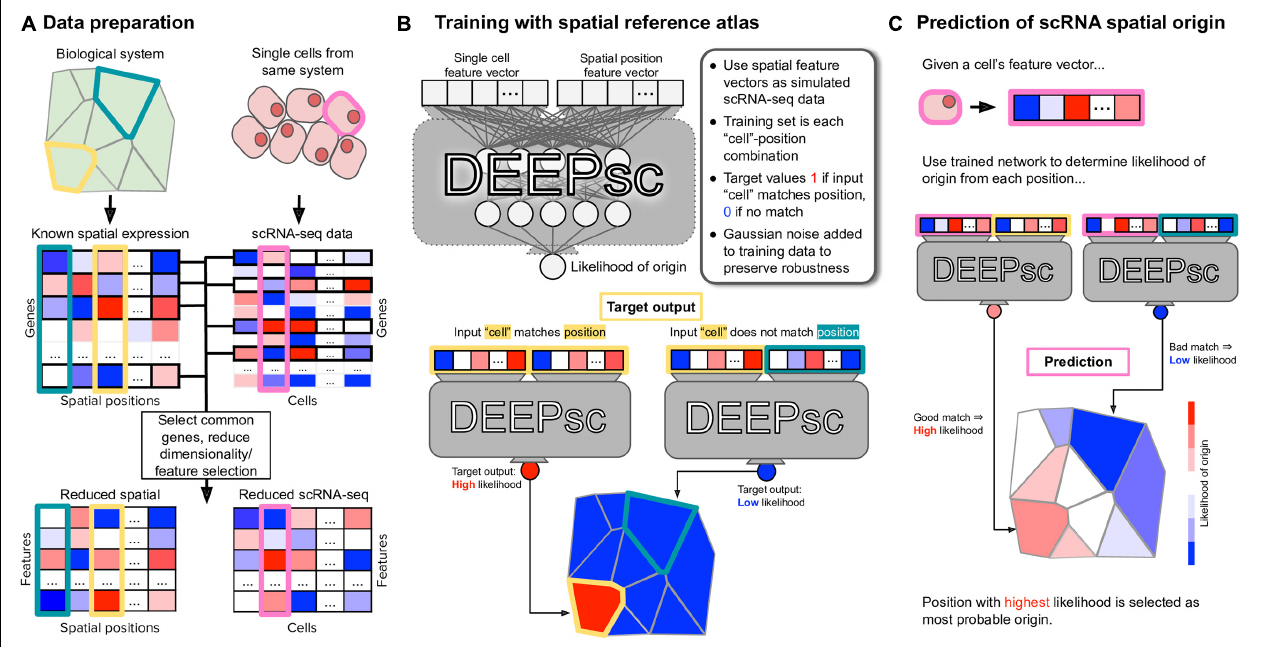
FIGURE 1 | The general workflow of training and implementing DEEPsc. (A) Given a spatial reference atlas of gene expression levels for some biological system and a scRNA-seq dataset, genes common to both are selected, and dimensionality of the data is reduced (e.g., by PCA, UMAP). Each spatial position in the reference atlas and each cell in the scRNA-seq dataset is associated with a feature vector in the reduced space. (B) The DEEPsc architecture takes as input the feature vectors of one single cell and one spatial position, returning a likelihood between 0 (low likelihood) and 1 (high likelihood) that the cell originated from the spatial position. A DEEPsc network is trained using the spatial position feature vectors as simulated scRNA-seq data. The target output is a 1 (high likelihood of origin) if the simulated input cell matches the input position, and 0 (low likelihood of origin) if they do not match. (C) Once the DEEPsc network is sufficiently trained, a feature vector associated with a cell in the scRNA-seq dataset can be fed into the network with each spatial position individually. The resulting likelihoods are displayed as a heatmap depicting the likelihood of origin of the cell from each position. The position with the highest likelihood is chosen as the origin of the cell. This process is repeated for each cell in the scRNA-seq dataset.